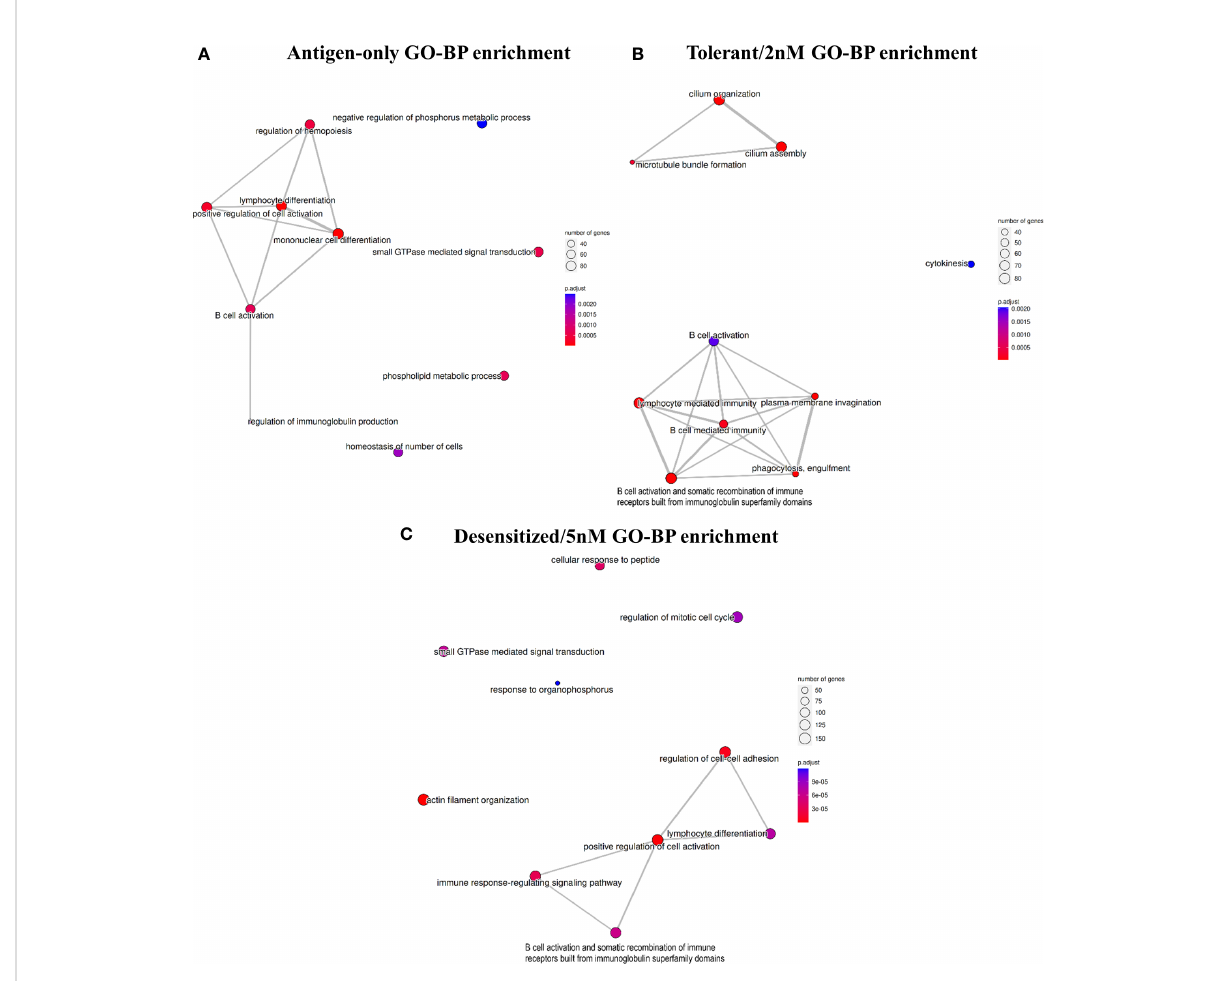
FIGURE 3 Top 10 enriched gene ontology terms in the biological processes category for each comparison: (A) Antigen-only versus Anaphylactic, (B) Tolerant/2nM versus Anaphylactic, and (C) Desensitized/5nM. Terms are connected if there were shared genes between the set of genes enriching each